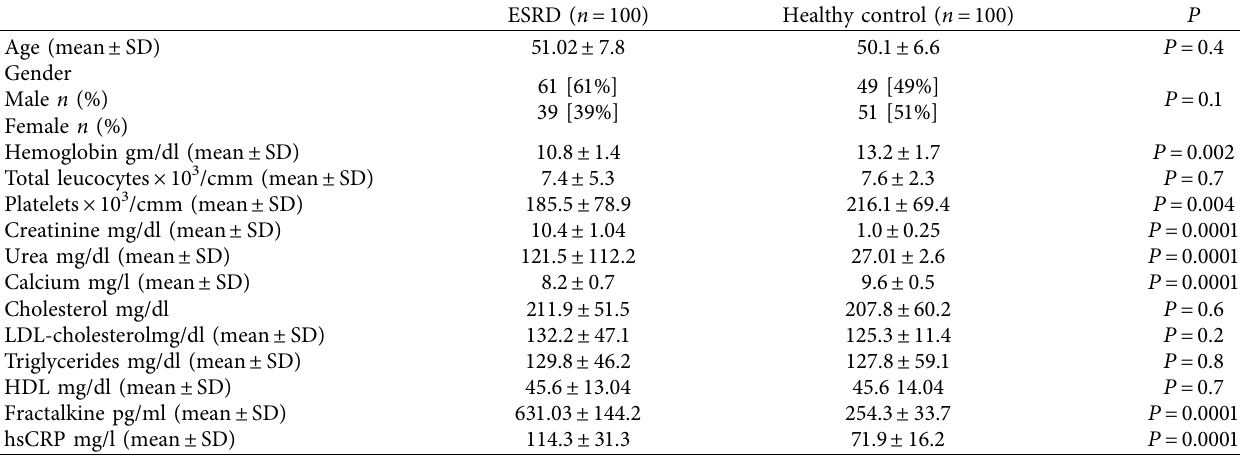
Table 1: Comparison of demographic and laboratory data between patients and control group.